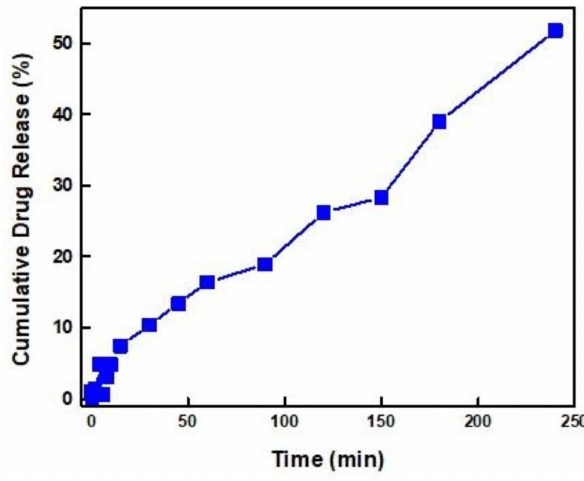
Figure 11. Release of IND from P(DMAEMA 28 -co-Q 12 DMAEMA 28 )- b -POEGMA 86 containing nanoaggregates under